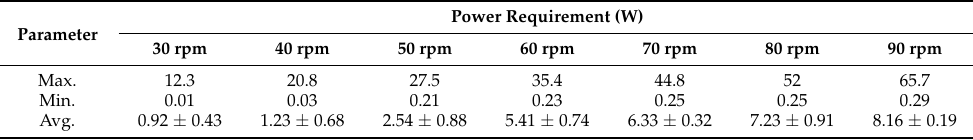
Table 8. Power requirements (W) at different rotational speeds (rpm) for the planting mechanism.